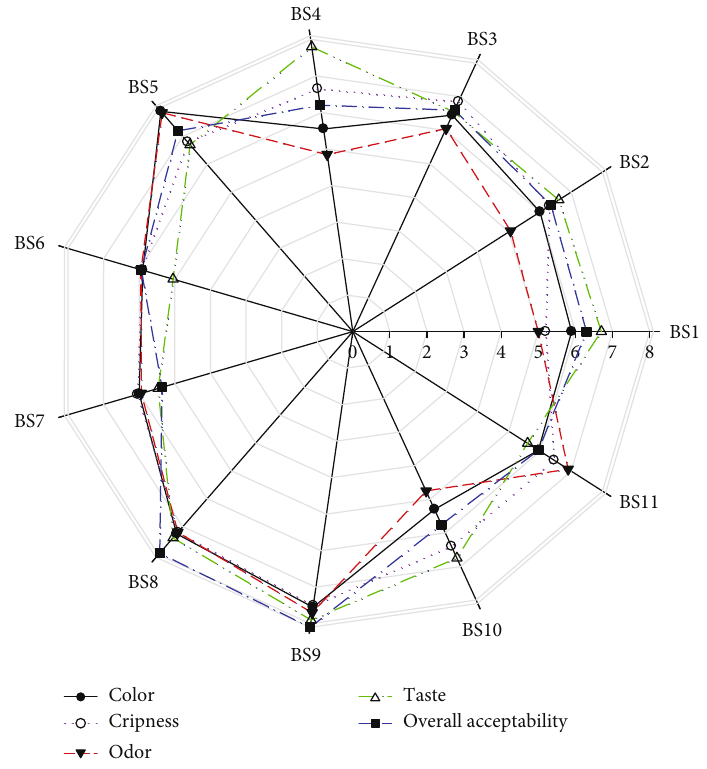
Figure 2: Radar plot showing the sensorial parameters of the di ff erent